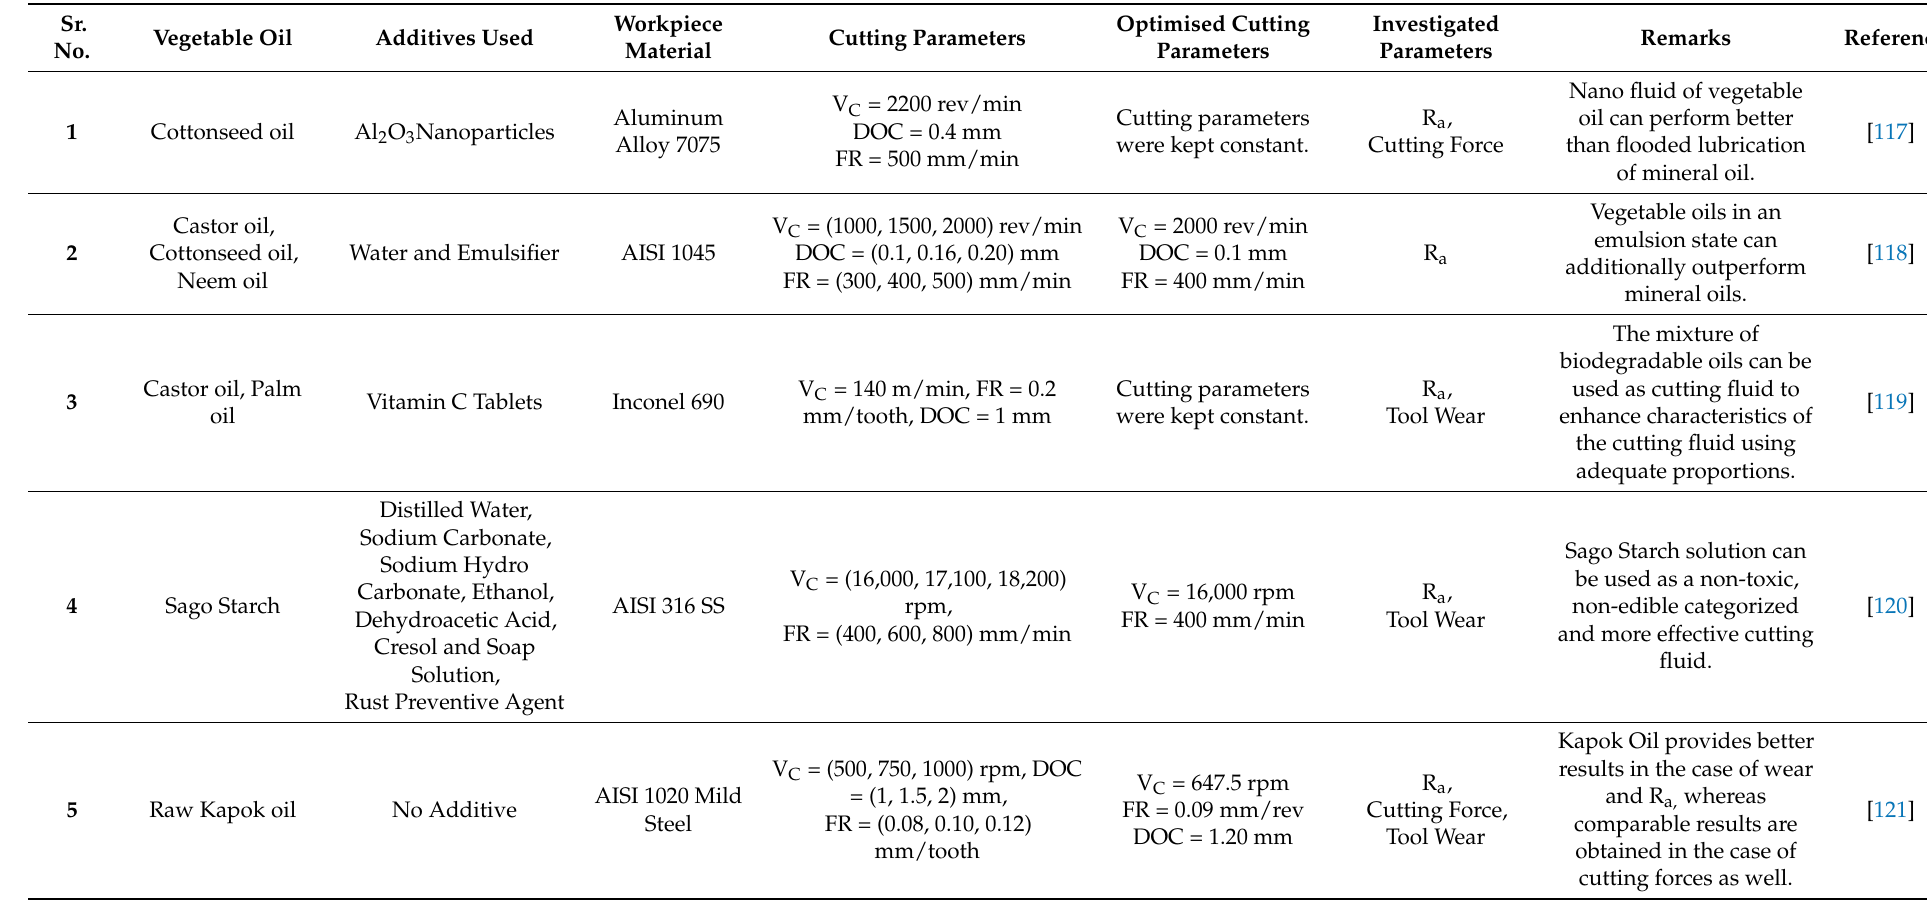
Table 6. Milling Operation Using Non-Edible Vegetable Oil-Based Cutting